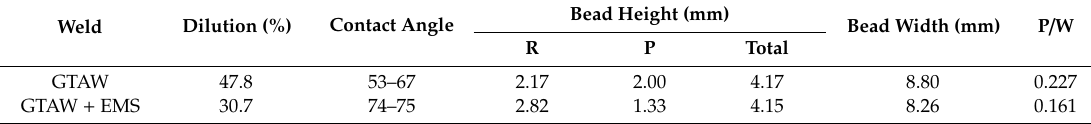
Figure 6. The macrographs of the weld cross-sections by ( a ) GTAW and ( b ) GTAW + EMS. Table 3. The dimensions of the welds.